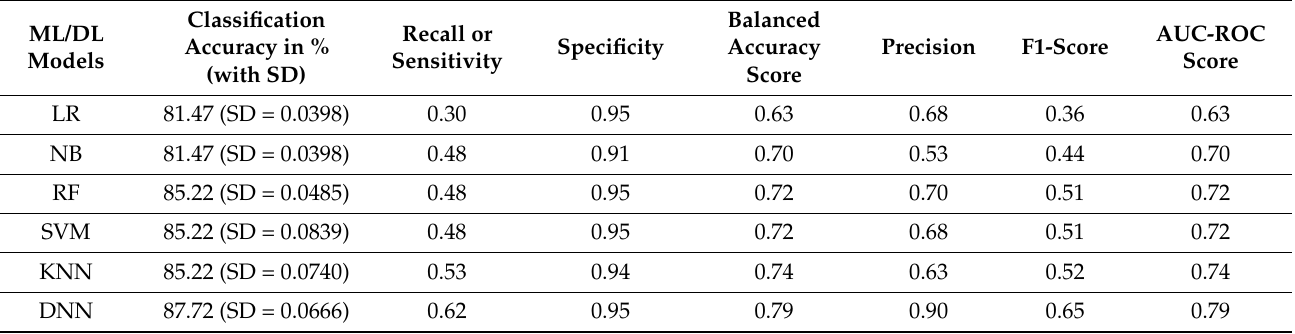
Table 3. The comparative performance estimation using different ML/DL models based on the stratified five-fold